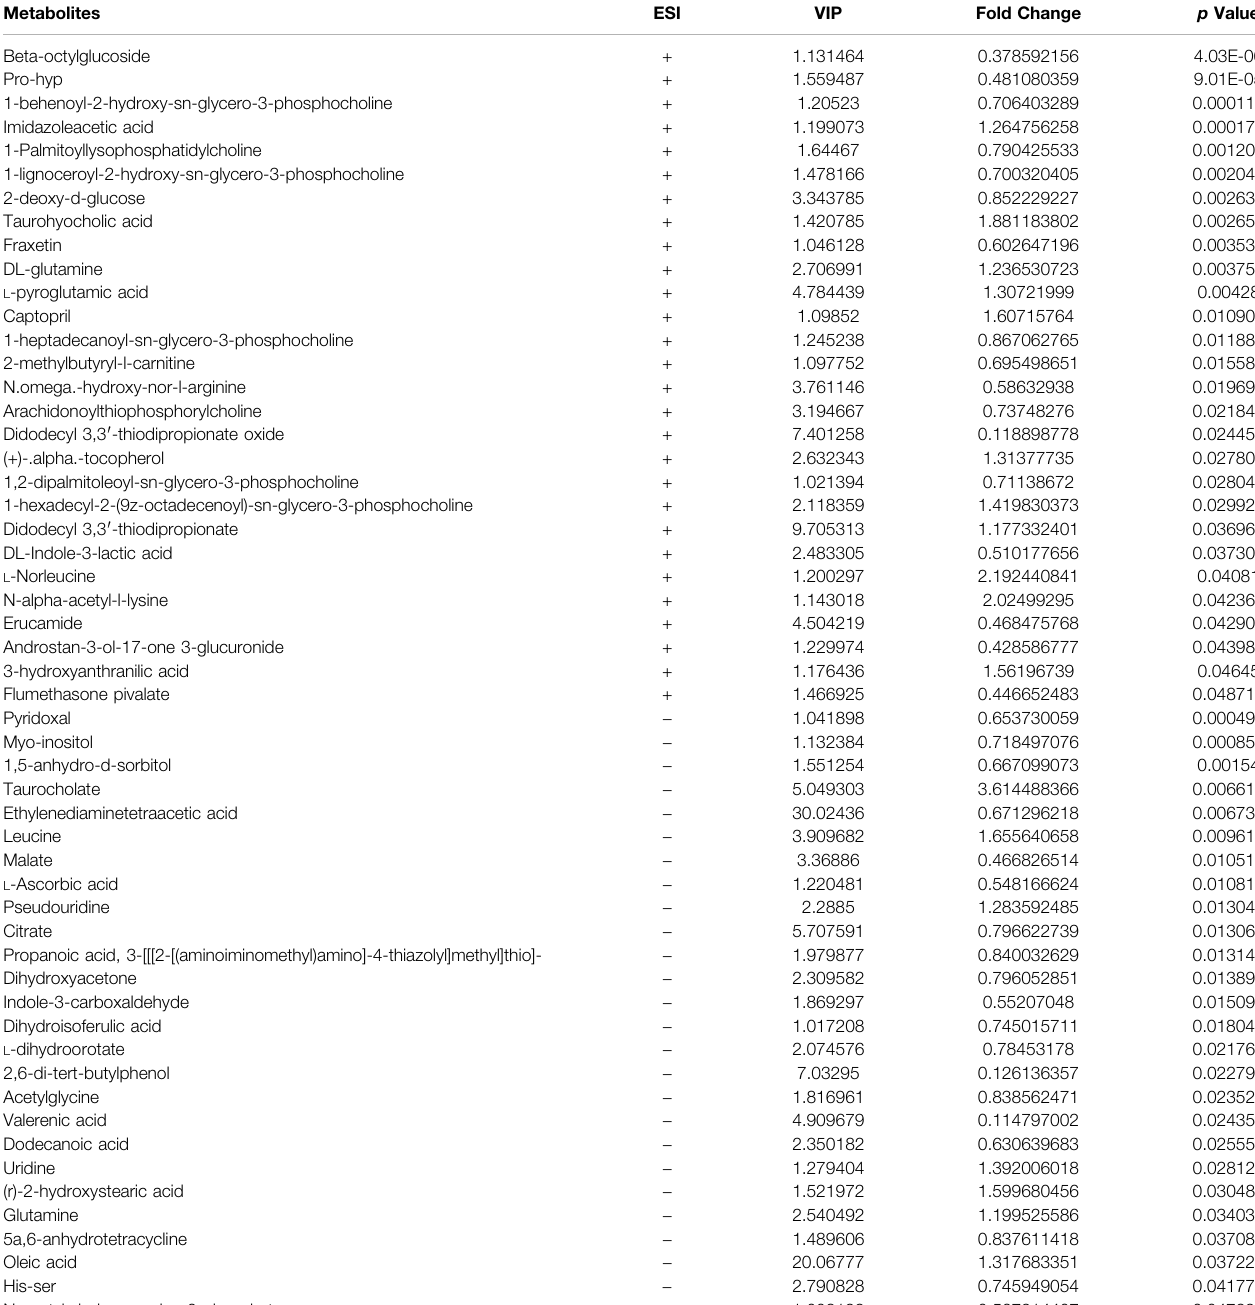
TABLE 1 | Differentiated plasma metabolites between model and control groups. Metabolites ESI